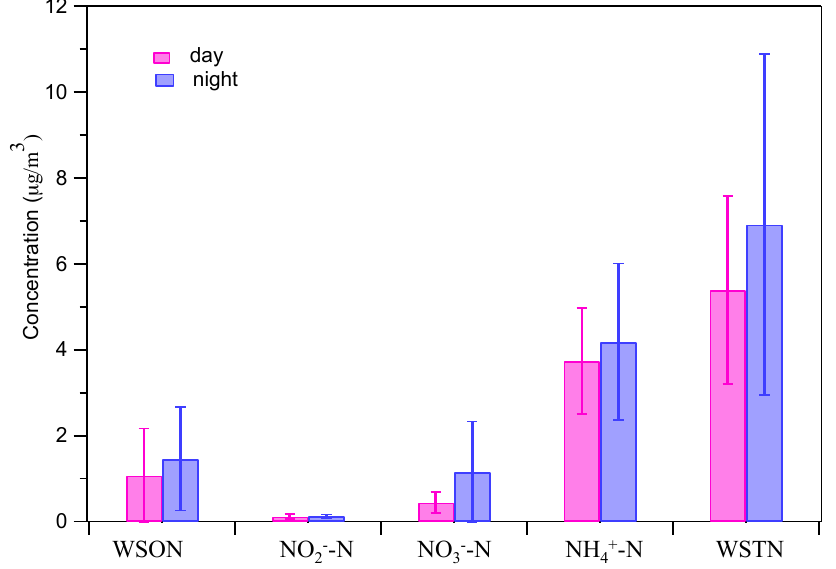
Figure 8. Mass concentrations of N-containing components in PM 2.5 during daytime and nighttime (error bar represents one standard deviation).